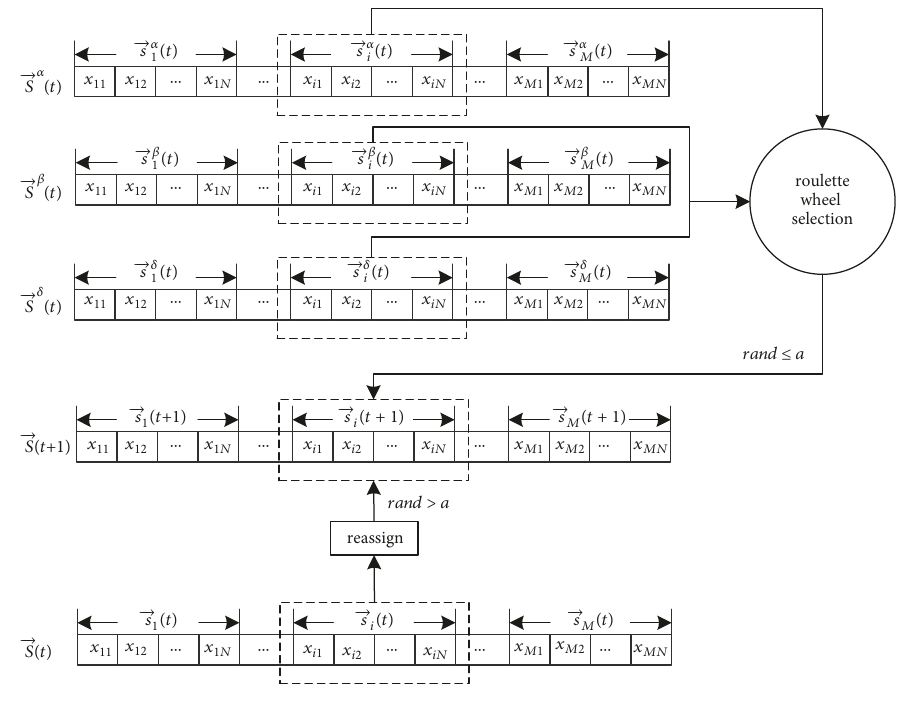
Figure 3: The mechanism of the modular position update method.